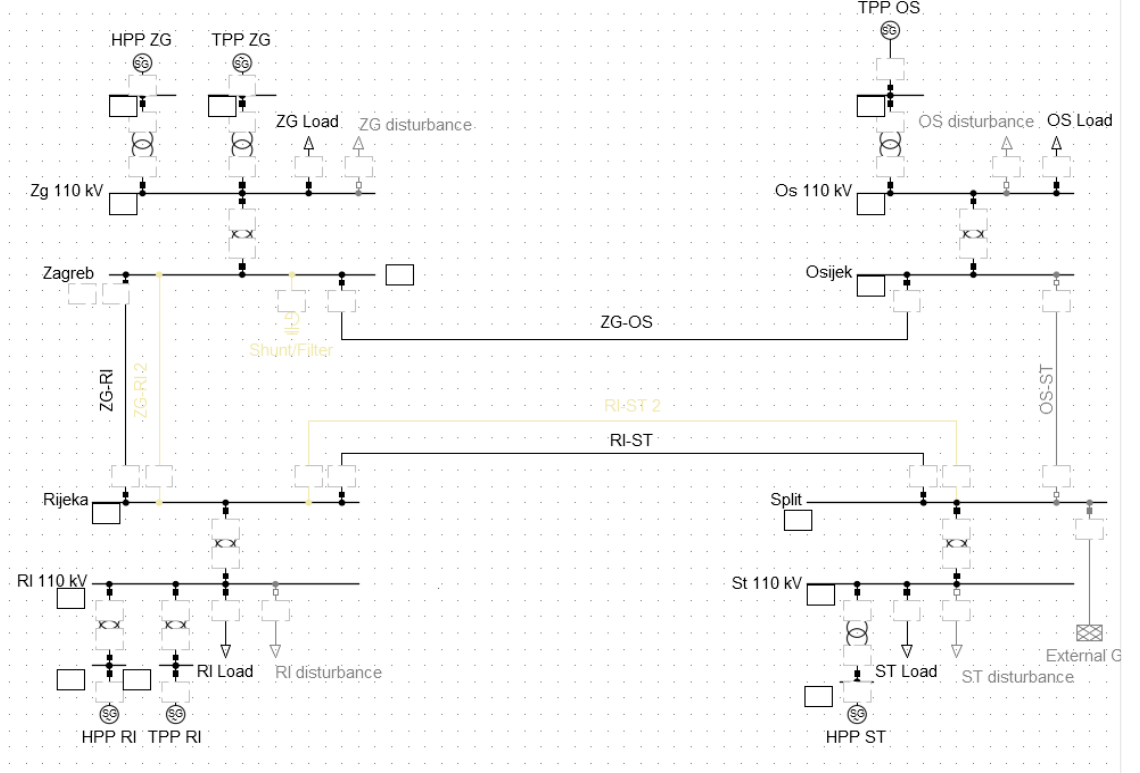
Figure 7. Reduced system model of the Croatian power system.